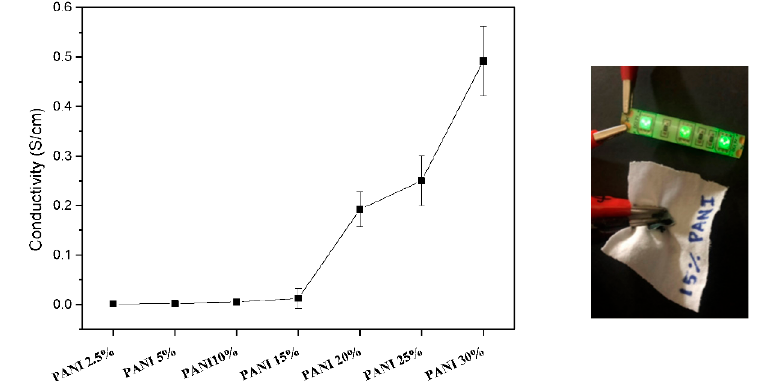
Figure 10. Electrical conductivity for SF composite mats with different added amounts of PANI.